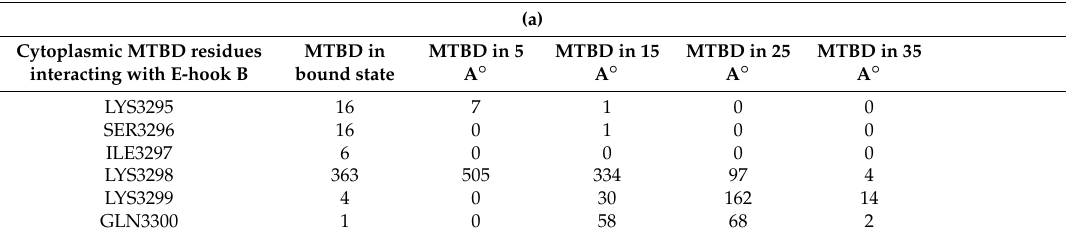
Table 2. The total number of contacts between the corresponding E-hook and MTBD residues. ( a , b ): MTBD residues interacting with E-hook B for cytoplasmic and axonemal MTBD, respectively; ( b , d ): The same with E-hook D for cytoplasmic and axonemal MTBD, respectively.